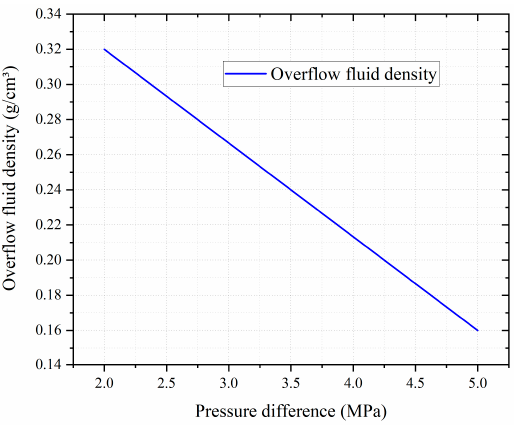
Figure 11. Influence of pressure difference on overflow fluid